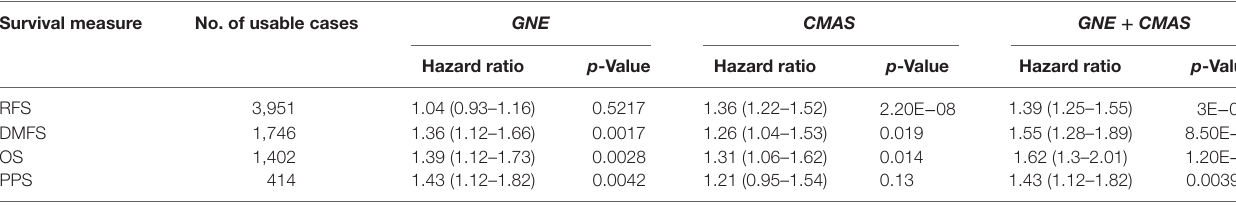
TaBle 1 | Summary of hazard ratios and p -values from Kaplan–Meier curves. survival